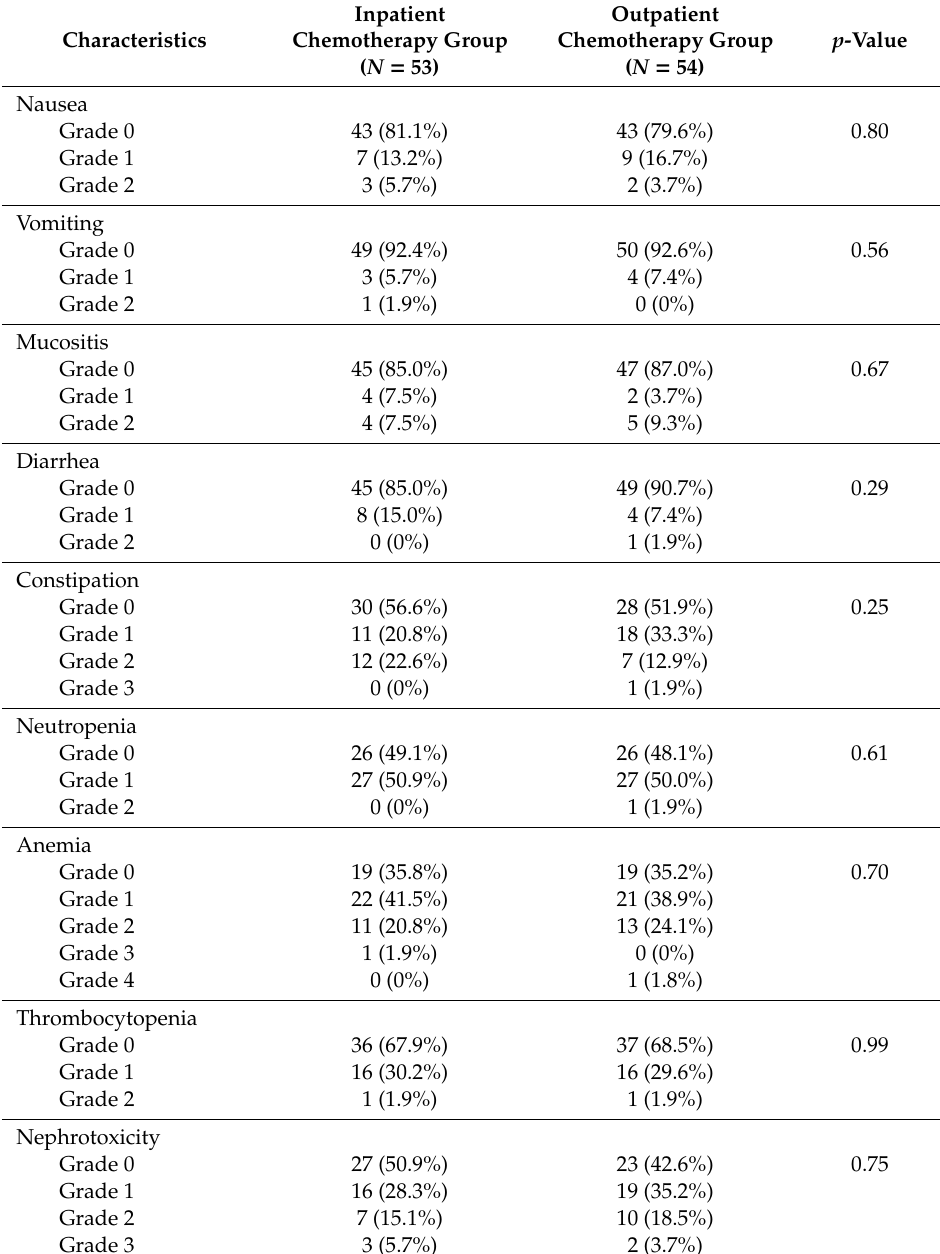
Table 4. Comparison of adverse events in 107 patients with esophageal squamous cell carcinoma who received inpatient or outpatient